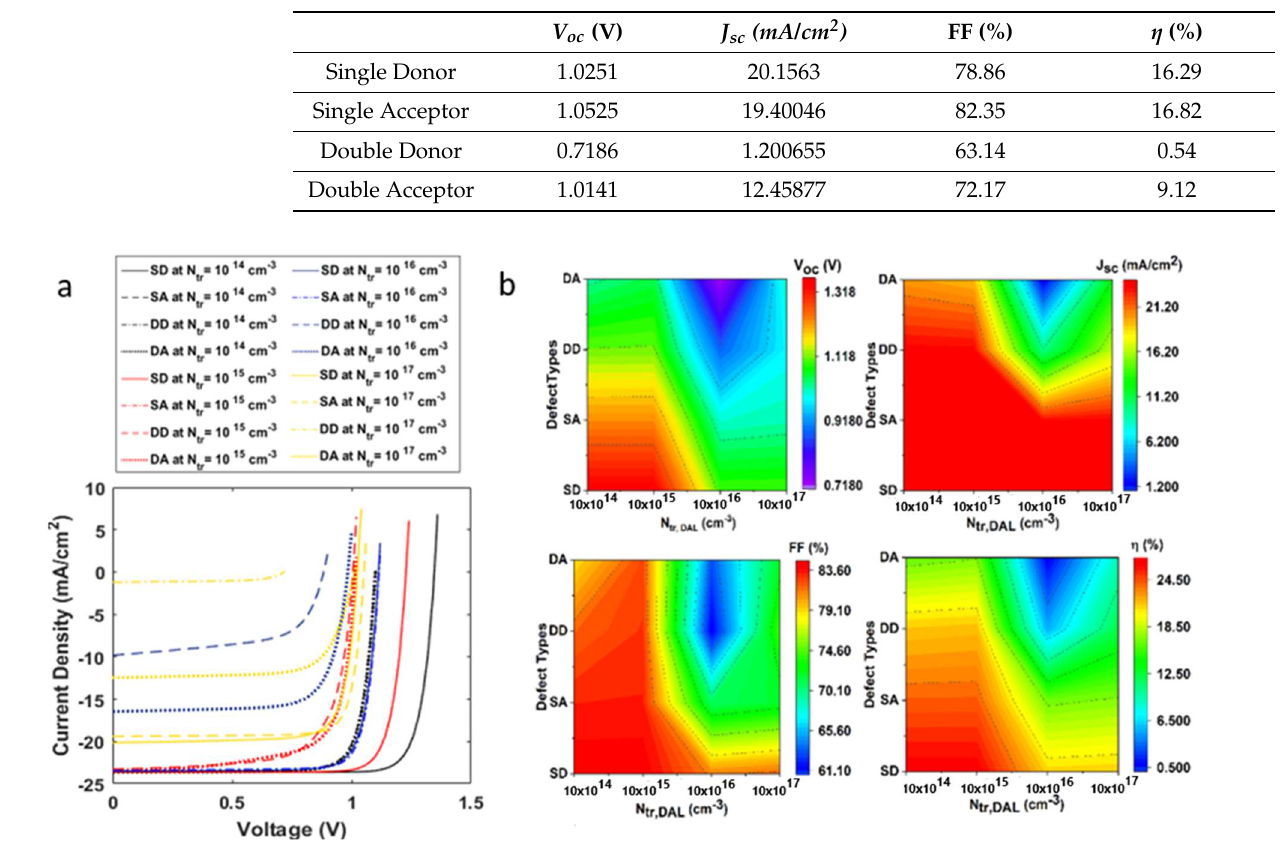
Figure 8. ( a ) Current–voltage characteristics of a solar cell on inclusion of metastable defect states with varying trap densities ( b ) Influence of metastable defect states, single donor (SD), single acceptor (SA), double donor (DD), and double acceptor (DA), at varying defect densities, on open-circuit voltage, short-circuit current density, fill factor and efficiency of the solar cell.